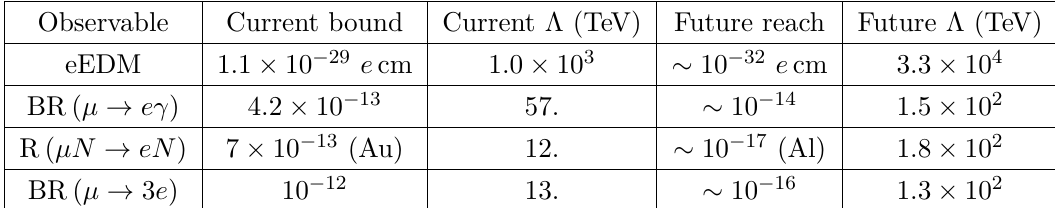
m µ = eg 2 . The ij 16 π 2 Λ 2